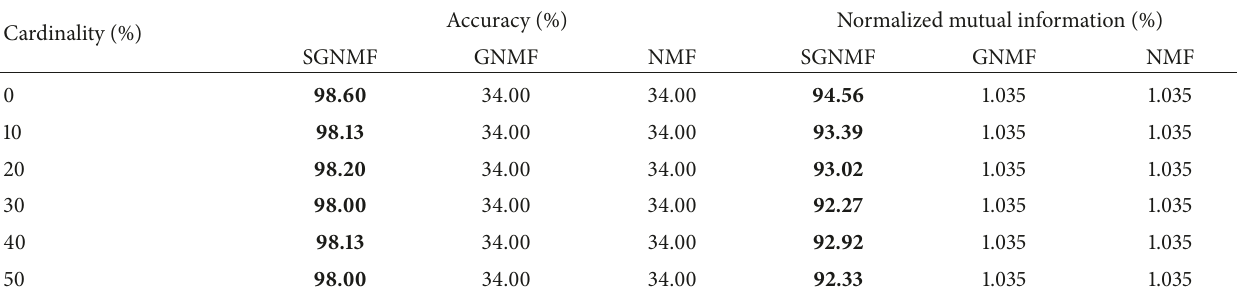
Table 8: Clustering performance on IRIS in case 2 .